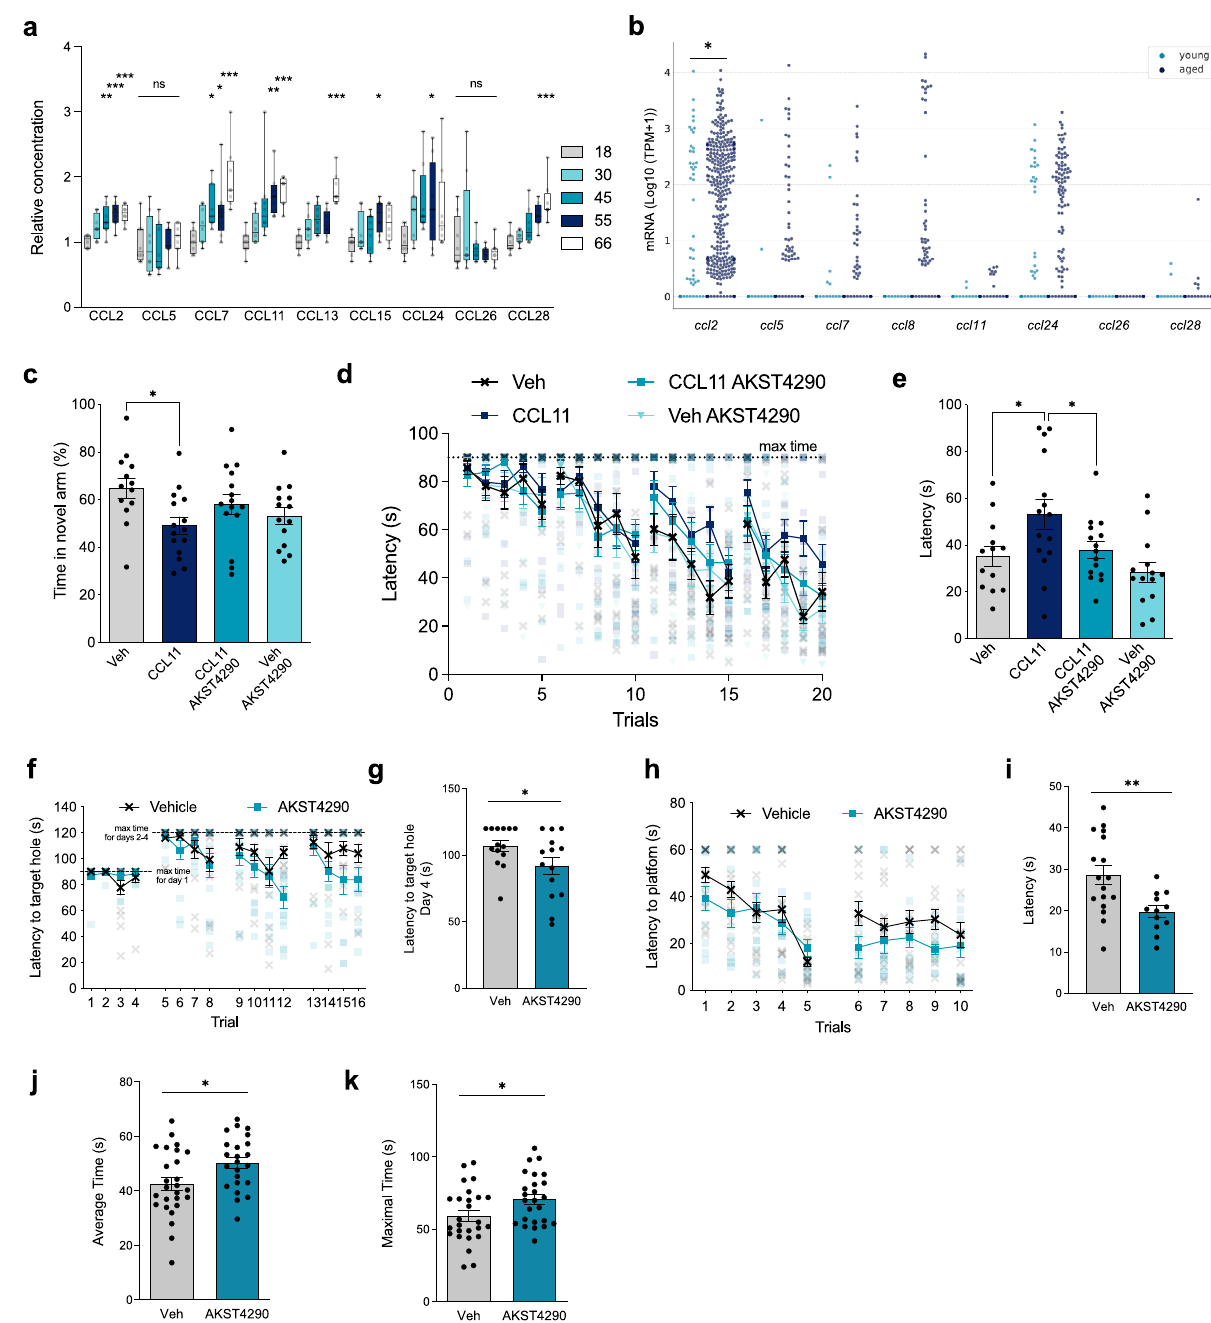
Fig. 1 Plasma chemokines increase with aging, with impact on memory and motor function. a CCR3 ligands measured from pooled plasma samples from individuals in different age groups ( n = 8; * p < 0.05, ** p <0.01, *** p <0.001, **** p < 0.0001; Kruskal Wallis with Dunn Test). b Single cell RNA-seq expression analysis of CCR3 ligands in microglia from young and old C57Bl/6dentate gyrus. Swarm plots show expression values in transcripts per million (TPM) for each gene for cells from young (light blue) and aged (dark blue) animals. Each dot represents the expression value of the respective gene in one cell (* p < 0.05; Benjamini – Hochberg corrected; MAST package, see methods). c – e Behavioral analyses conducted on 2-month-old C57Bl/6 mice treated with vehicle (Veh) ( n = 11), recombinant CCL11 i.p. ( n = 15), recombinant CCL11 i.p. with AKST4290 p.o. ( n = 15), and AKST4290 p.o. (14). c Percent time spent in novel arm in the Y-Maze test ( n = 11, 15, 15, 14); * p < 0.05; one-way ANOVA and Kruskal – Wallis test). d Latency time in seconds to fi nd the escape hole on all days of testing in Barnes Maze ( n = 11, 15, 15, 14; **** p < 0.0001; Marginal Survival Analysis and Cox Proportional Hazards). e Average latency time in seconds to fi nd the escape hole over the last 3 trials on the fi nal day of testing ( n = 11, 15, 15, 14; * p < 0.05; Mann – Whitney test). f – k Behavioral analyses conducted on 21- month-old C57Bl/6 mice treated with vehicle or AKST4290 for 5 weeks. f Time taken to fi nd the target hole on each day in the Barnes Maze test ( n = 14; **** p < 0.0001; Marginal Survival Analysis and Cox Proportional Hazards). g Average latency to fi nd target hole on last day of Barnes Maze test ( n = 14; * p < 0.05; Mann – Whitney test). h Time taken to fi nd platform for each trialover 2 daysin the RAWMtest ( n = 17, 12). i Average latency to fi nd the platform for each day in the RAWM test, from an average of 5 trials each day ( n = 17, 12; ** p < 0.01; Mann – Whitney test). j Average time mice were able to stay on the rotarod over the 3 trials during the testing phase of Rotarod ( n = 26, 23; * p <0.05; unpaired t -test). k Maximum time mice were able to stay on across the 3 trials during the testing phase of Rotarod ( n = 26, 25; * p <0.05; unpaired t -test;). All data shown are mean±standard error of the mean. COMMUNICATIONS BIOLOGY| (2023) 6:292 |https://doi.org/10.1038/s42003-023-04665-w|www.nature.com/commsbio